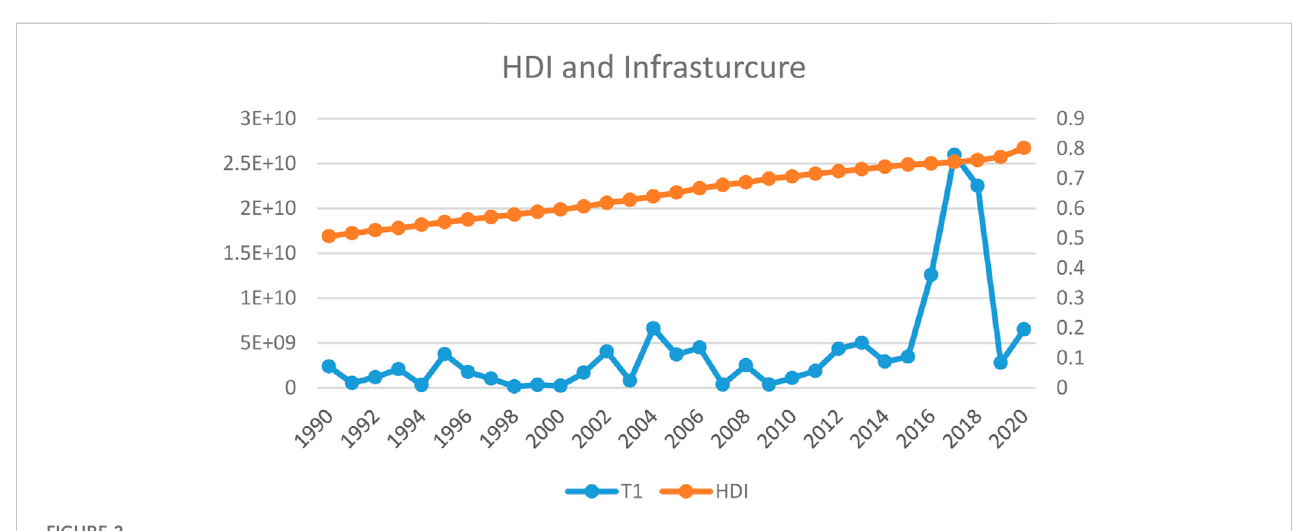
FIGURE 2 Hdi and